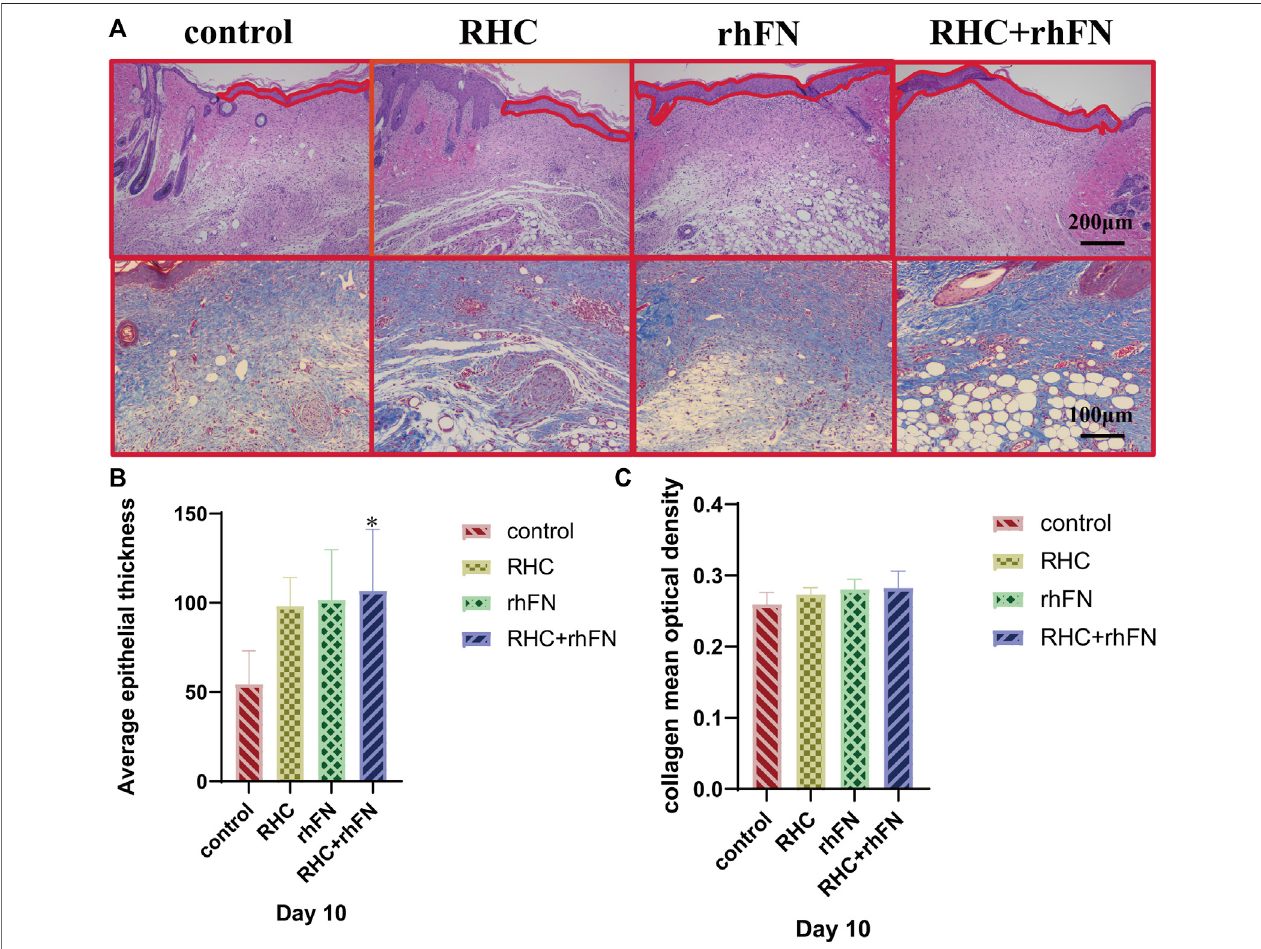
FIGURE 7 | The analysis of histology. (A) Representative H&E staining images on PID 10. Scale bar = 200 μ m. Representative Masson staining images on PID 10. Scale bar = 100 μ m. (B) Calculation and comparison of average epithelial thickness on PID 10. Data are presented as the mean ± SD ( n = 5). Statistical analysis: p p < 0.05. (C) Calculation and comparison of collagen mean optical density on PID 10. Data are presented as the mean ± SD ( n = 5). Statistical analysis: ns p >